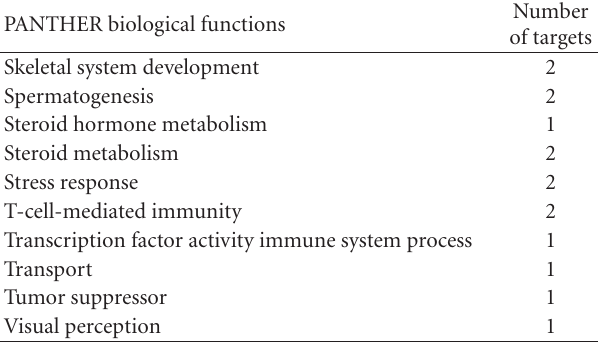
Table 4: Continued. Table 5: Distribution of berberine’s targets in vitro according to pathway